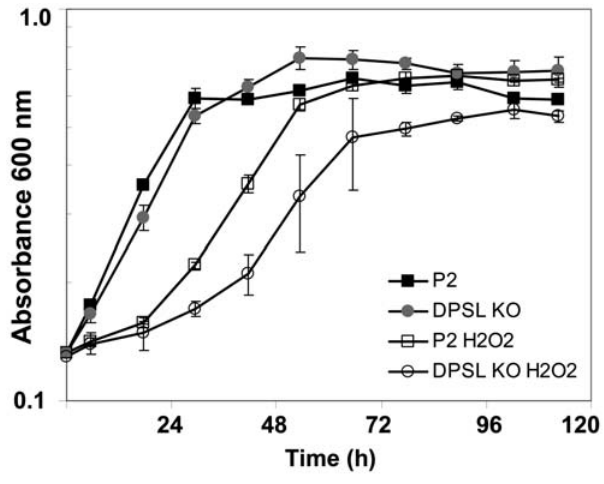
Figure 7. DPSLdeficientstrainof S.solfataricus ismore sensitive to H 2 O 2 . S. solfataricus (P2) and a mutant lacking DPSL (DPSL KO) were cultured with and without 30 m M H 2 O 2 . P2 (solid square), P2 with H 2 O 2 (open square),DPSL KO (gray circle), DPSL KO with H 2 O 2 (open circle) n=3.